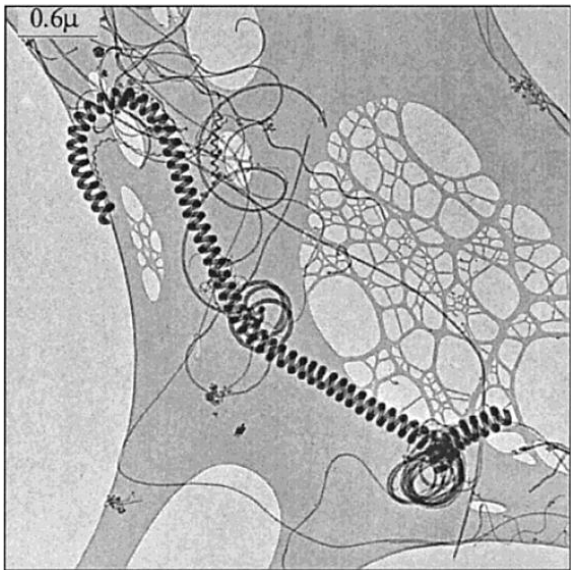
Figure 8. A typical coil, with its regular pitch. Reproduced from [25] with permission.